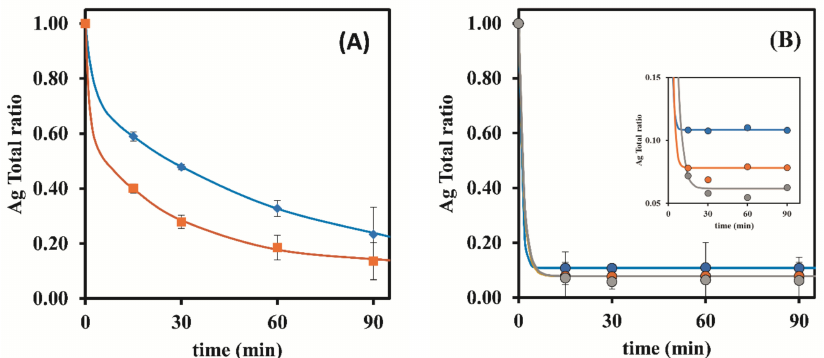
Figure 2. Influence of stirring and resin mass (Dowex 50W-X8 50–100 mesh) on the Ag Total ra- tio. ( A )—S-OFF; ( B )—S-ON ( • —0.25 g of resin; • —0.50 g of resin; • —1.00 g of resin); inset in ( B )—amplification of results in the Figure 2B comprising Ag Total ratios till the value of 0.15. The represented values are the average of three replicates for each different assay.